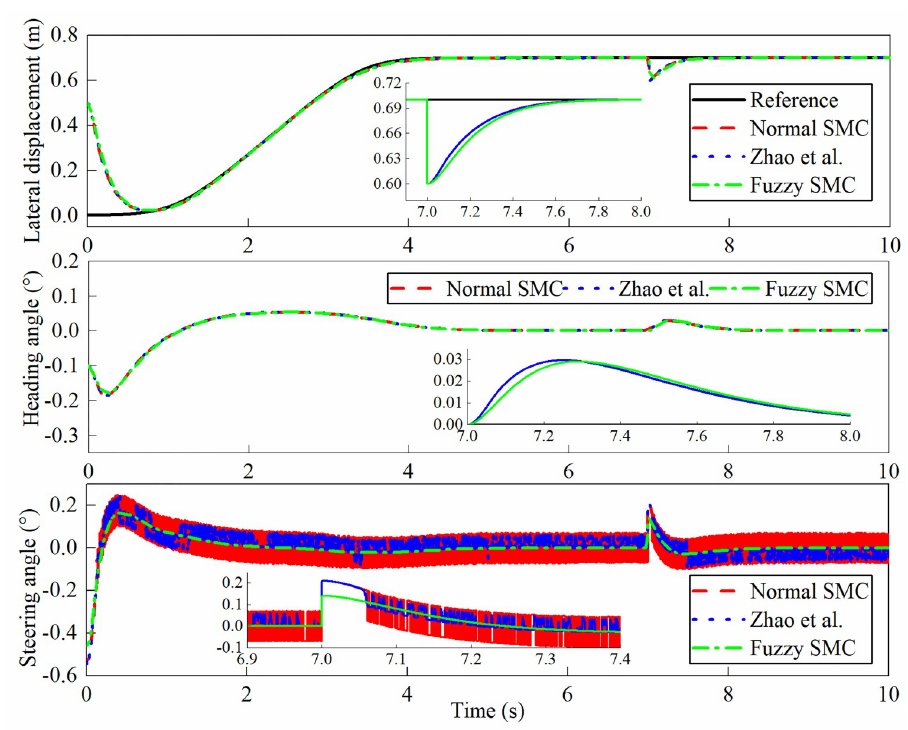
Fig 16. Lateral displacement, heading angle, steering angle with